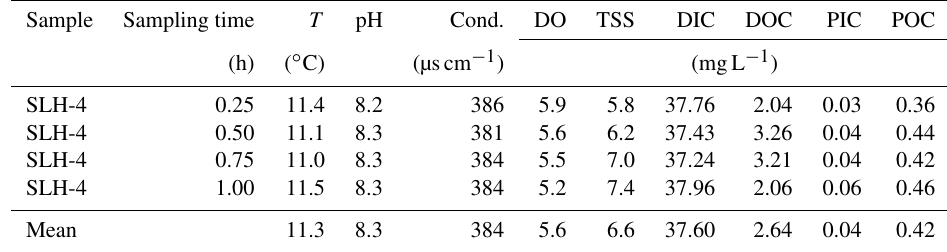
Table 2. River water properties at the SLH-4 station of Shaliu River during a precipitation event in August 2015. Sample Sampling time T pH Cond. DO TSS DIC DOC PIC POC (h) ( ◦ C) (µscm − 1 ) (mgL − 1 ) SLH-4